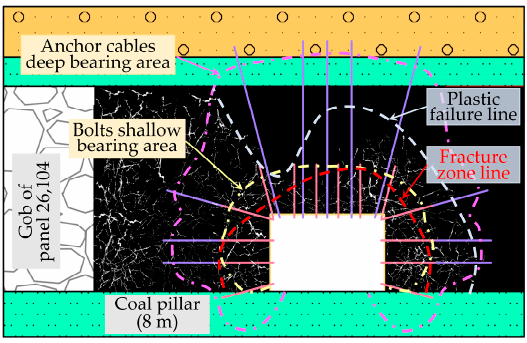
Figure 13. Cooperative bearing structure of bolts and anchor cables.